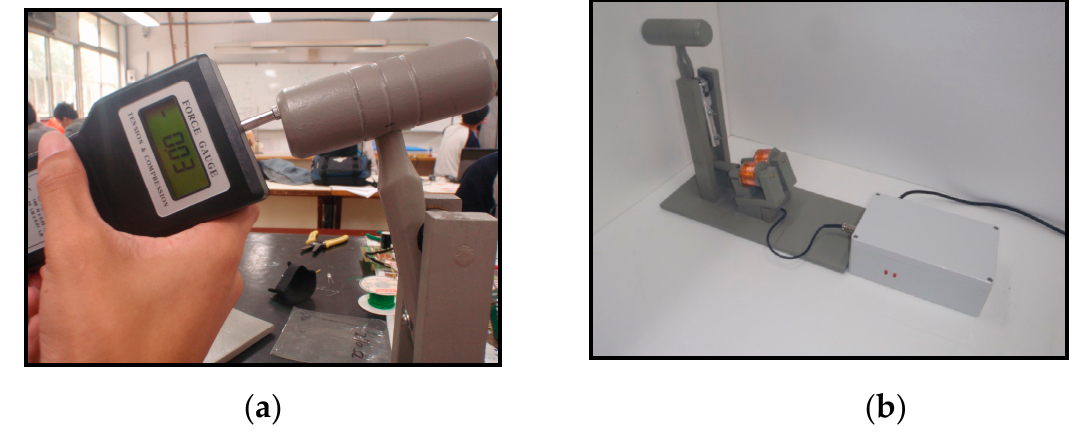
Figure 5. Schematic of hardware–software connection.